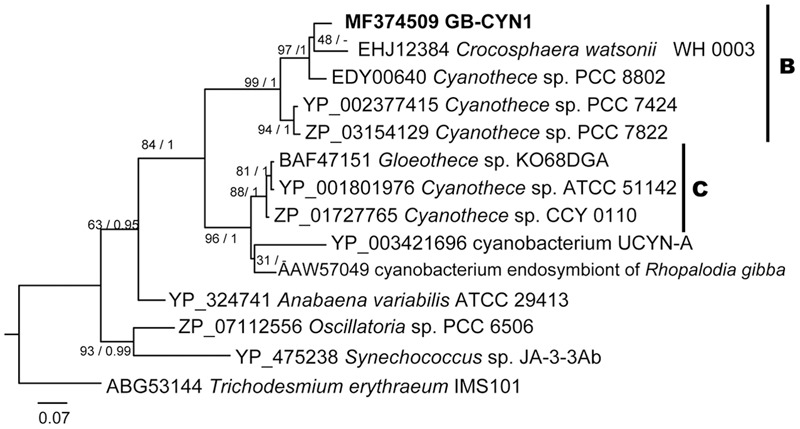
Maximum likelihood and Bayesian NifH phylogenies of GB-CYN1 species and related cyanobacteria. Near-full length NifH amino acid sequence from GB-CYN1 (267aa, from assembled metagenomic contig) was aligned with full length reference sequences. Numbers at the nodes indicate bootstrap values from maximum likelihood analysis (1000 replicates) and the posterior probability of the Bayesian tree inference. The Bayesian consensus tree was concordant with maximum likelihood tree topology except where indicated by a dash. Scale bar represents the mean number of amino acid substitutions per site. The major clades of unicellular cyanobacteria (UCYN-A-C) are labeled according to Zehr et al. (2001), Langlois et al. (2005), and Foster et al. (2007).